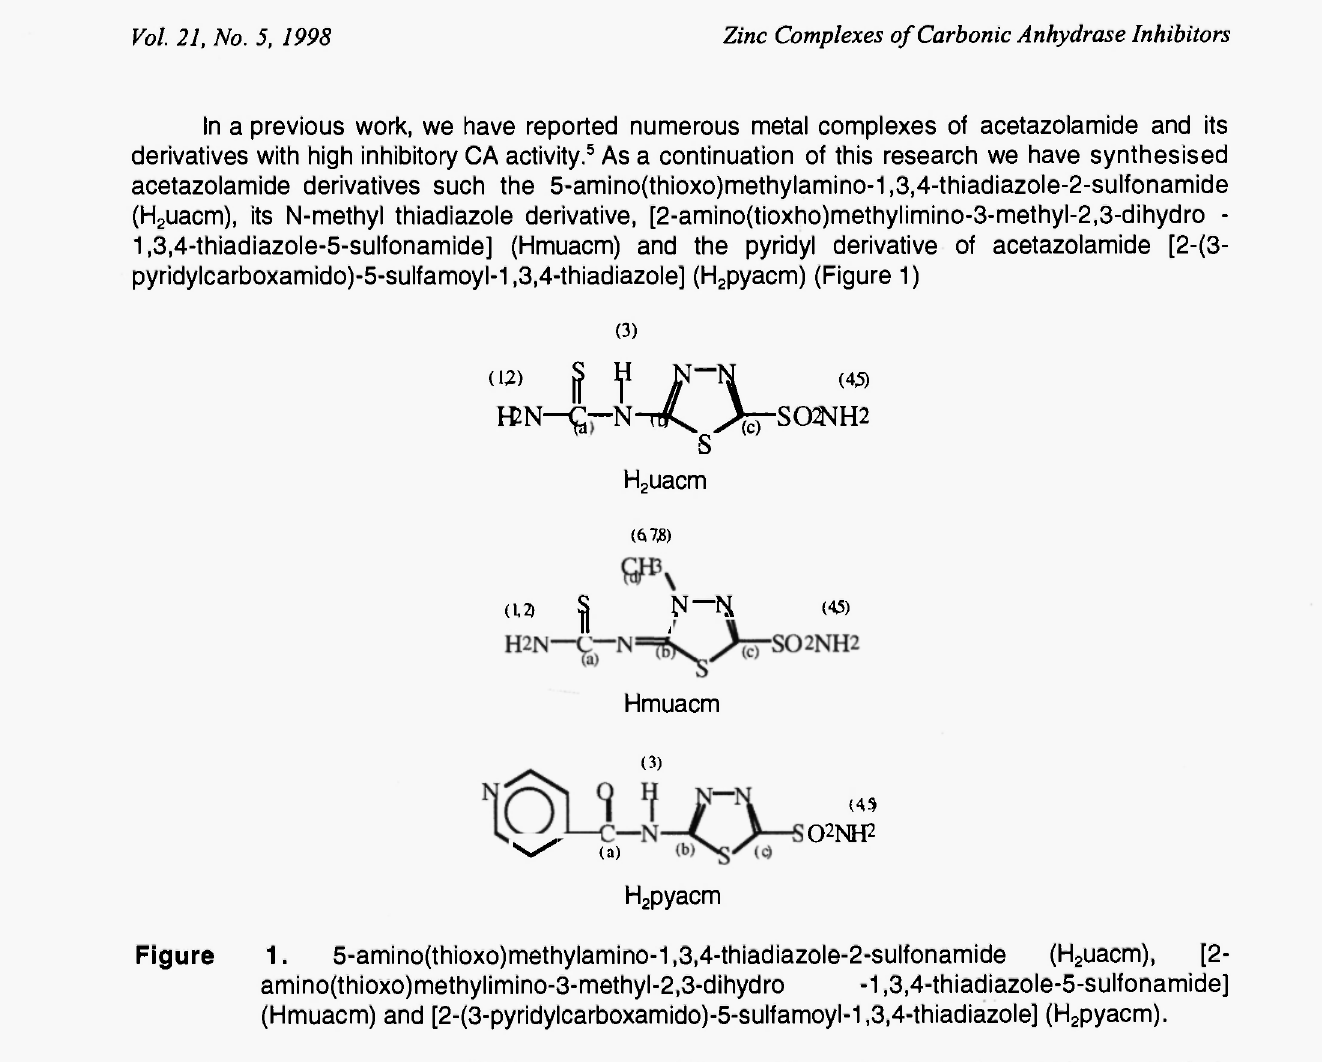
1. 5-amino(thioxo)methylamino-1,3,4-thiadiazole-2-sulfonamide (H amino(thioxo)methylimino-3-methyl-2,3-dihydro -1,3,4-thiadiazole-5-sulfonamide] (Hmuacm) and [2-(3-pyridylcarboxamido)-5-sulfamoyl-1,3,4-thiadiazole] (H